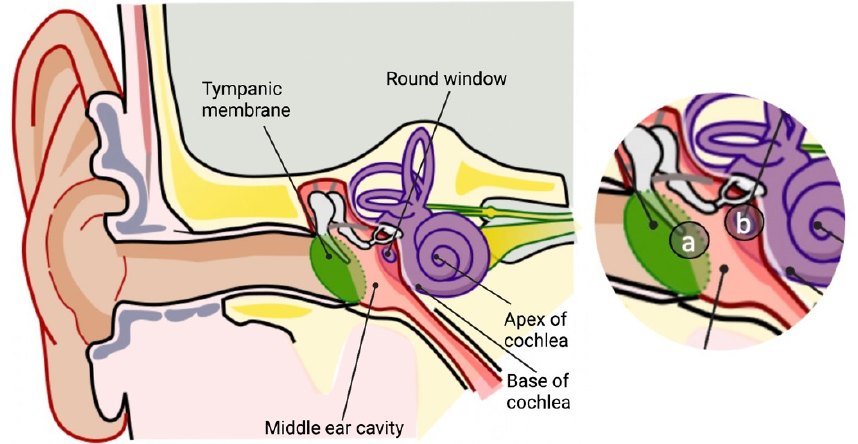
Figure 1. Routes of drug administration for inner ear treatments . Schematic representation of the anatomy of the ear. Inset , routes of direct drug injection: ( a ) intratympanic; ( b ) intracochlear through the round window (created with BioRender.com accessed on 9 September 2022).